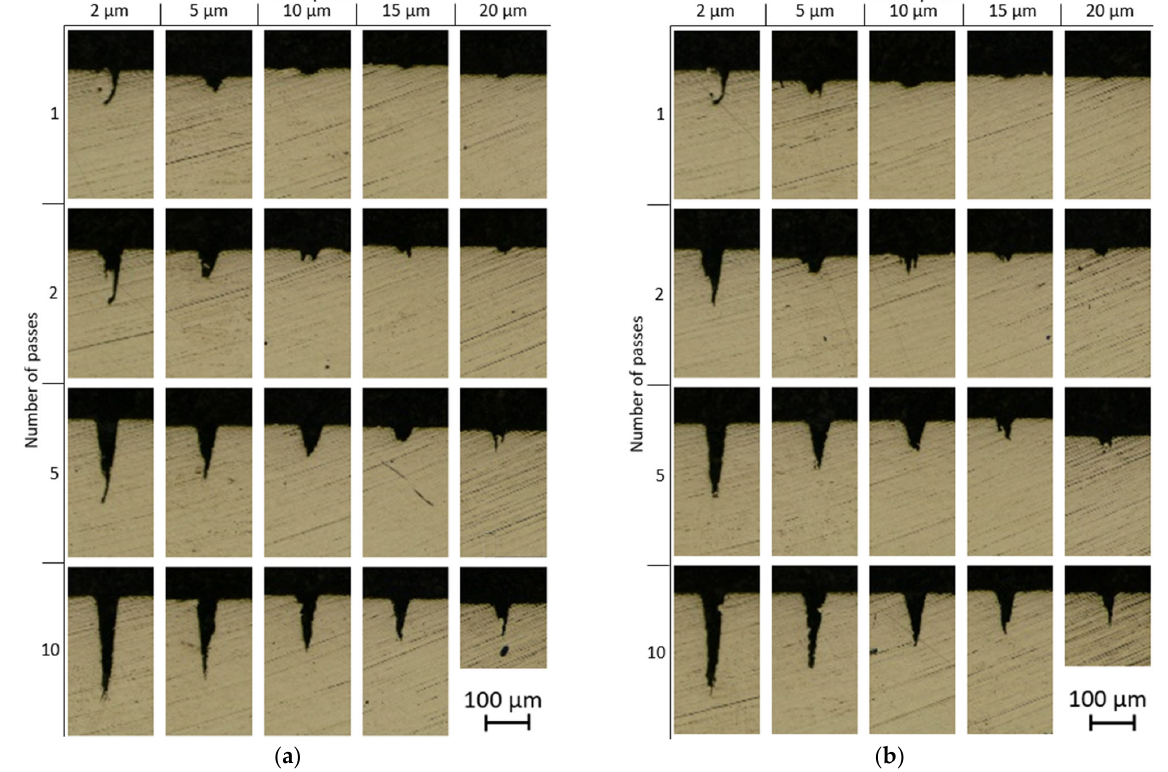
Figure 6. Cross ‐ sectional 7 mm profiles from the start of the grooves of ( a ) unidirectional and ( b ) bidirectional grooves, as a function of hatch pitch and the number of passes.